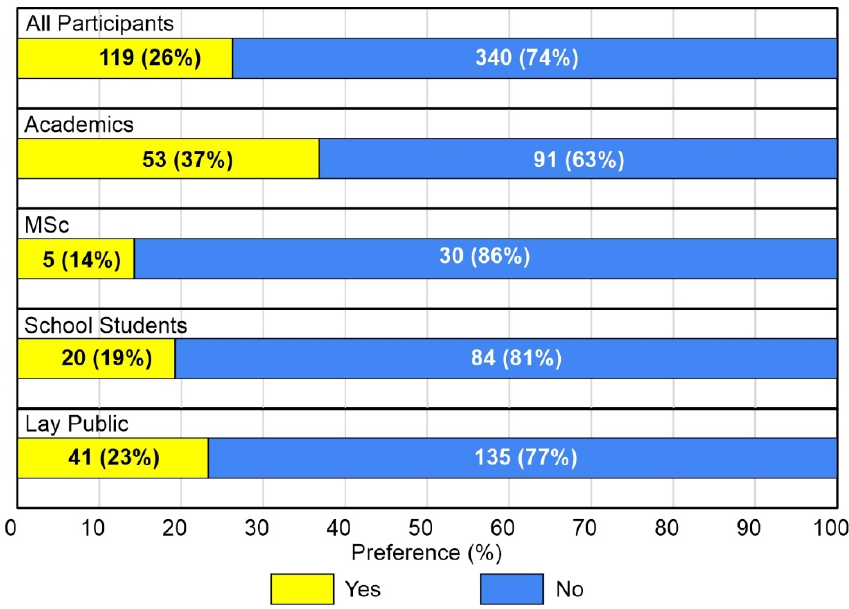
Figure 13. Bar charts showing possible side effects associated with the immersive virtual reality experience. The results represent both the total number of participants and the background of each group respectively.